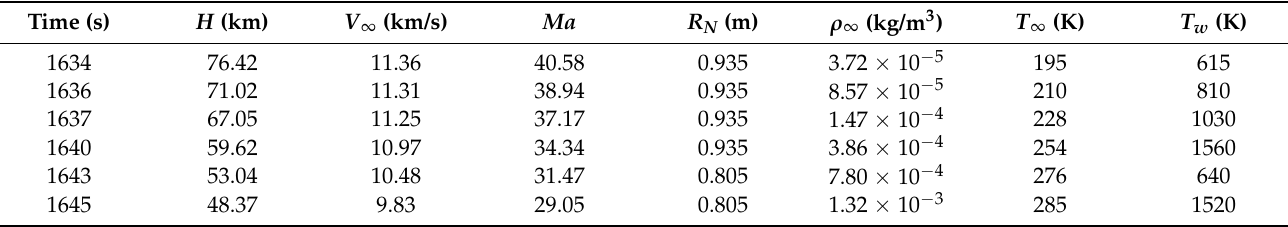
Table 2. Fire II flight conditions for the present